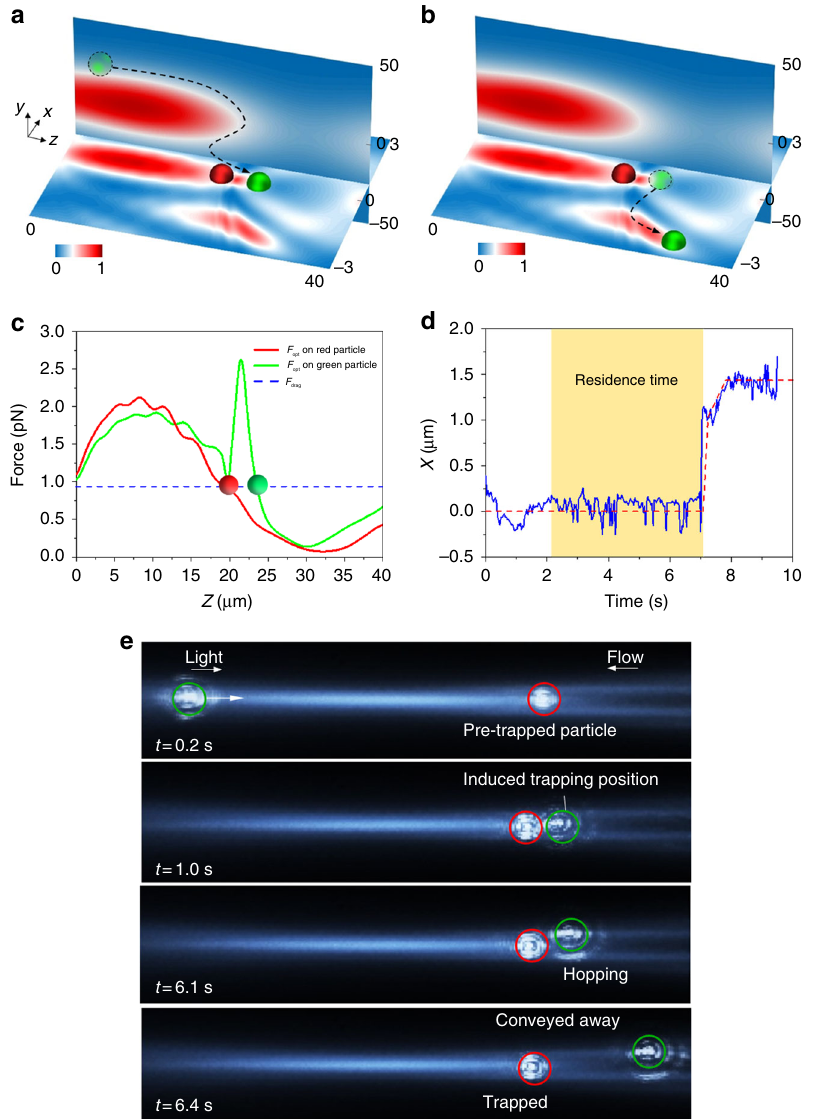
Fig. 2 Particle hopping from the extra trapping position caused by particle pre-trapping. Illustration of a the green particle being trapped in the extra trapping position and b hopping to the adjacent potential well. Optical intensity pro fi les at the x – z plane ( y = 0) and y – z plane ( x = 0) are plotted. c Force analysis on the 1 μ m polystyrene particle along the z- direction when x = 0, y = 0. Blue line represents the drag force. Red and green lines represent the optical forces on red and green particles, respectively. d Projection of the green particle trajectory on the x -axis. e Experimental demonstration of the 1 μ m particle hopping induced by the pre-trapped particle Snookering-like collision-induced hopping . For the case of particle collision-induced hopping, when the second (green) Table 1 Parameters for calculating the residence time of the particle originates from the x – z plane ( y = 0), it tends to be particle in the potential well at the extra trapping swiftly con fi ned in the centre of the beam ( x = 0) by the optical gradient force as shown in Fig. 3a and Supplementary Fig. 6. The green particle is pushed to the right by the optical scattering force in the z -direction. Simultaneously, thermal fl uctuation causes the green particle to vibrate in the x -direction. The green particle eventually collides with the pre-trapped red particle. This side-on collision can drive the red particle into the adjacent potential well occurs only when the red particle crosses the saddle point β of the (Fig. 3b). Before the collision, the red particle is trapped at the potential well. When the green particle collides with the red valley point of the potential well ’ s centre at point α (Fig. 3c), i.e., particle, the distance between the two particles is almost the same at x = 0, y = 0 and z = 20 μ m. The activation energy of the − 19 as that between the bottom and saddle points of the potential well J, which is potential barrier between points α and β is 7.5 × 10 (Supplementary Figs. 7 and 8). Once the green particle occupies 181 times the thermal energy of the red particle ( k B T ). Therefore, the valley point (point α ′ ) of the new potential well, the red the red particle is stably trapped in the potential well. Hopping